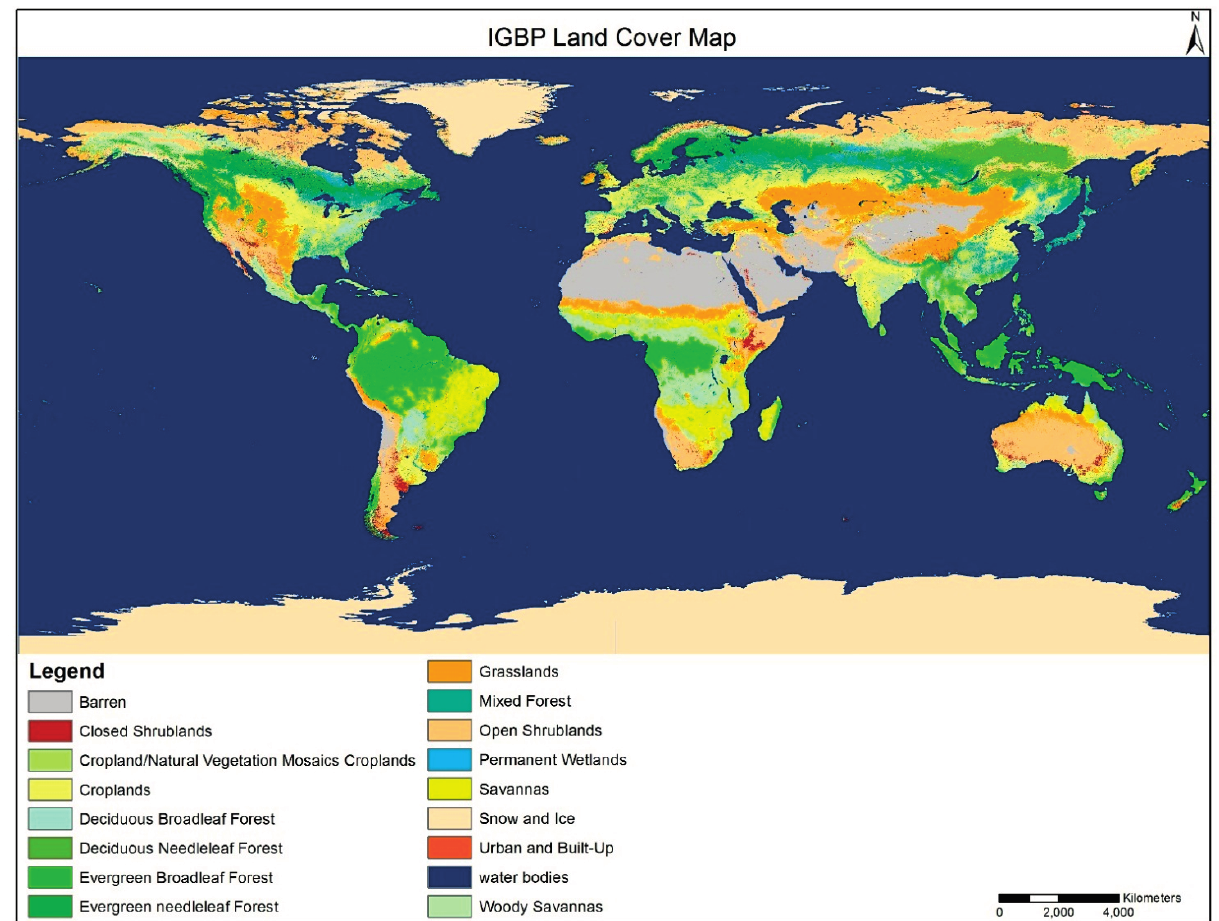
Figure 1. The IGBP Land Cover Map (figure generated from data obtained at